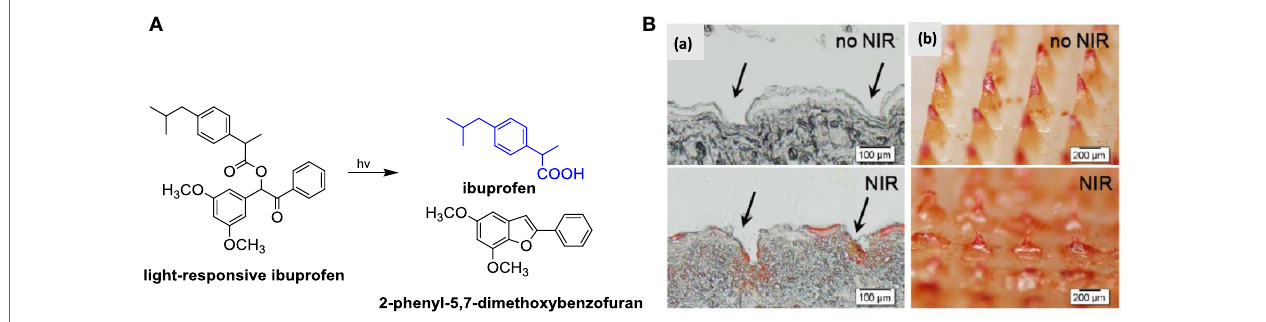
FigURe 6 | (A) Synthesis of light-responsive ibuprofen conjugates together with light-triggered release of ibuprofen from synthetic light-responsive conjugate. (b) (a) Histological sections and (b) bright-field micrographs of microneedles being removed from the inserted skin. The arrows indicate the microneedle insertion sites [reprint with permission from Chen et al.